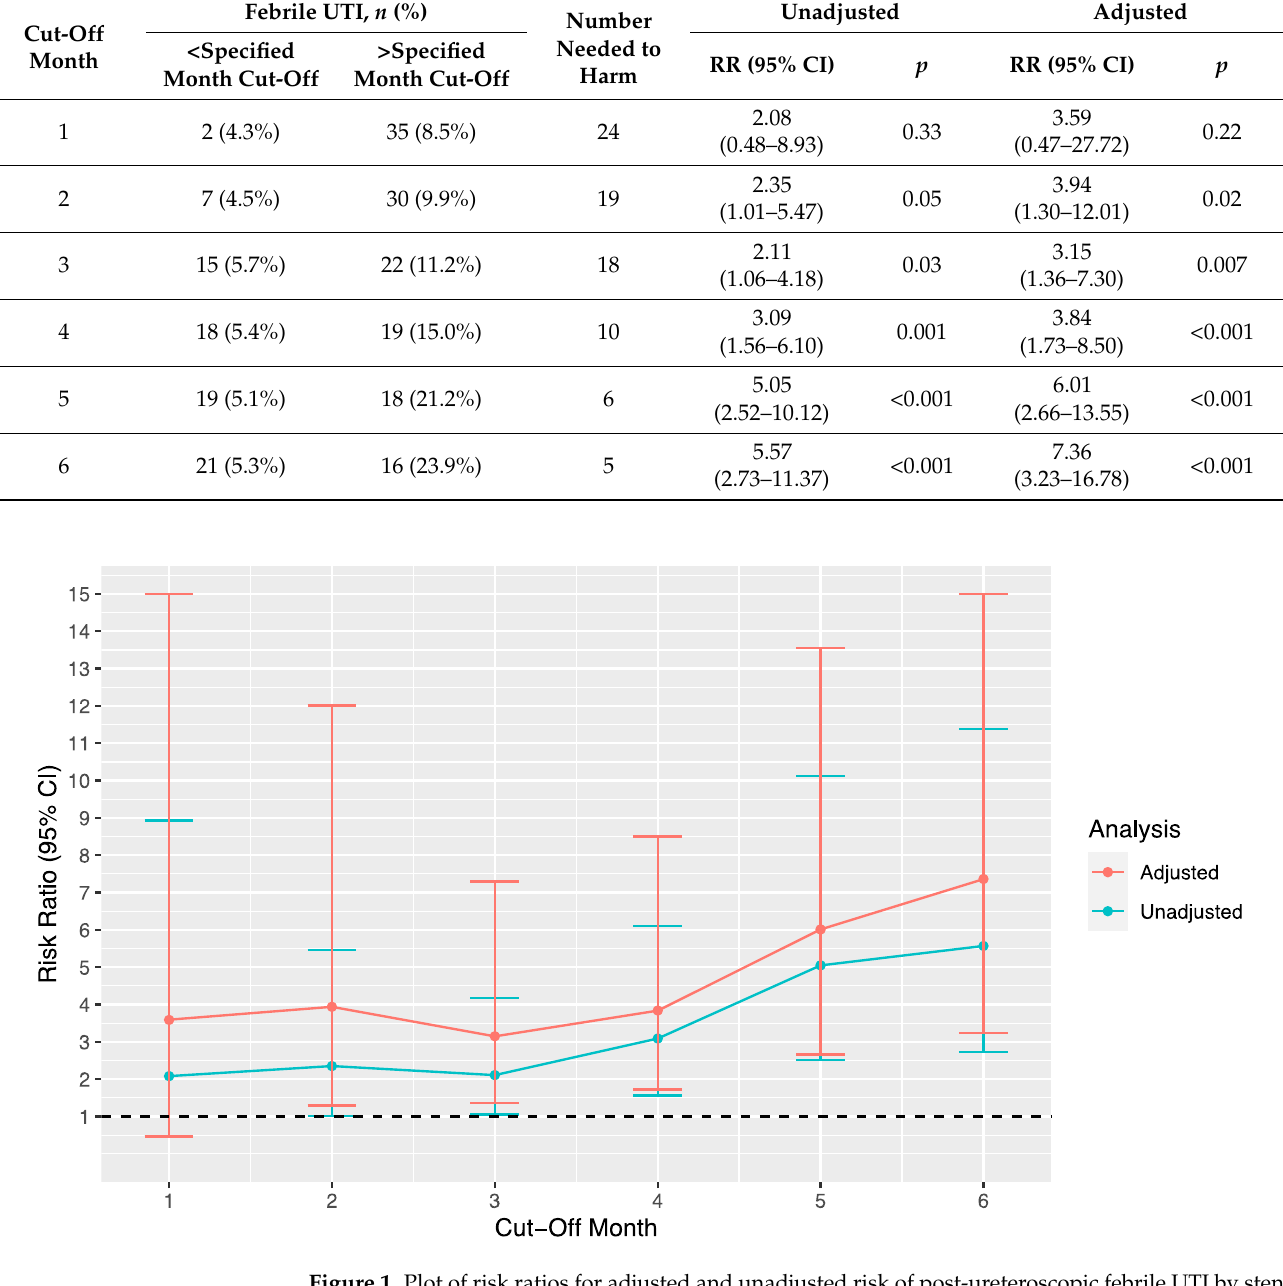
Figure 1. Plot of risk ratios for adjusted and unadjusted risk of post-ureteroscopic febrile UTI by stent dwell time cut-off month (e.g., <1 vs. >1 month). Error bars = 95% confidence interval. Reference line = 1, i.e., no difference in risk. = p < 0.0036 as per Bonferroni correction.